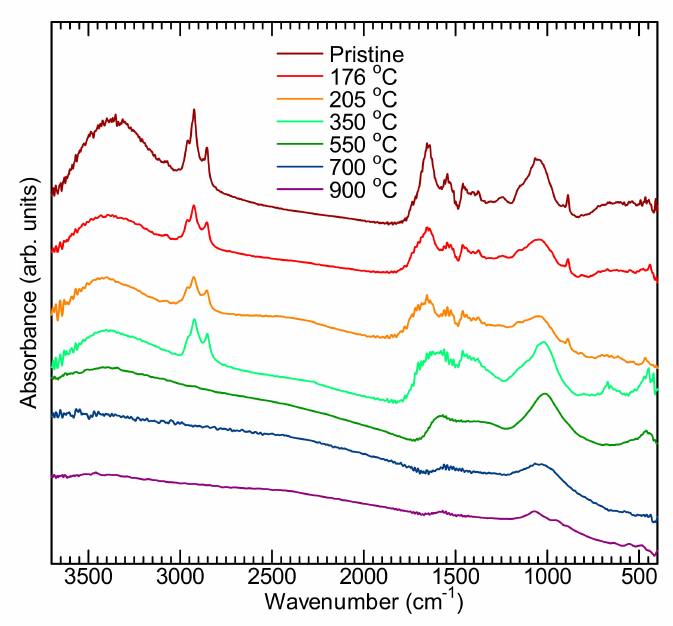
Figure 5. Infrared (IR) absorption spectra of the B. braunii residue before and after